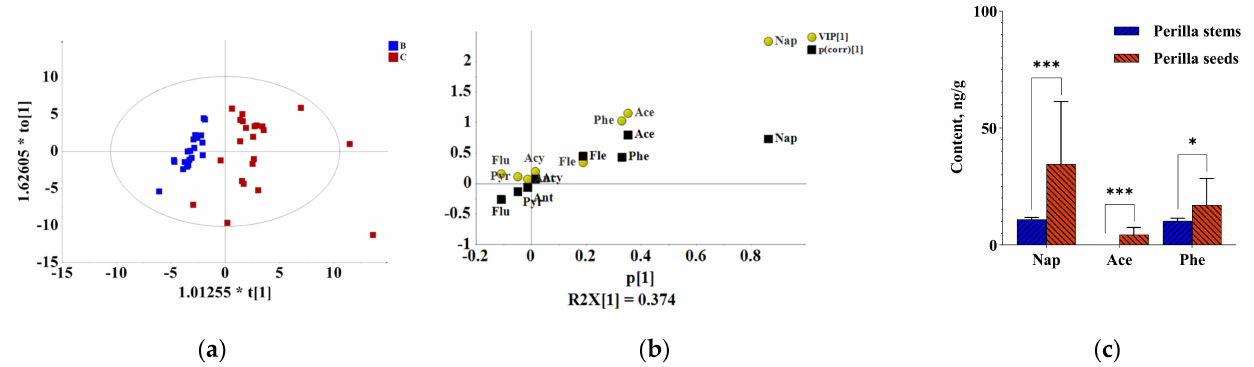
Figure 5. The difference between perilla stems (B) and seeds (C). ( a ) OPLS-DA score plot; ( b ) (V + S)- plot of OPLS-DA. ( c ) The contents of differential compounds ( C , ng/g) (*: p ≤ 0.05; ***: p ≤